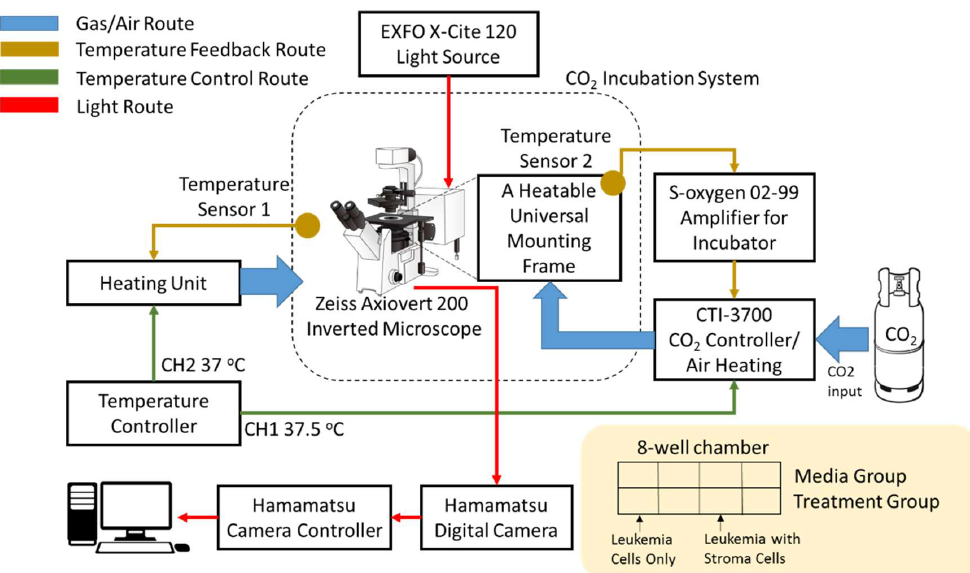
Figure 1. The schematic of the whole system framework for time-lapse cinematography is shown. The system consists of a gas/air route indicated with blue arrows, a temperature feedback route indicated with brown arrows, a temperature control route indicated with green arrows, and a light route indicated with red arrows. An 8-well chamber plated with leukemia cells and human stromal cells was used to monitor the motility of primary ALL cells.